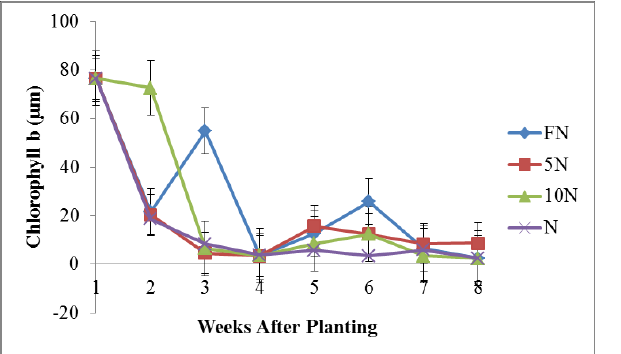
Fig. 2b. The effect of nitrogen nutritional stress on the chloro- phyll b accumulation of Zea mays measured at different